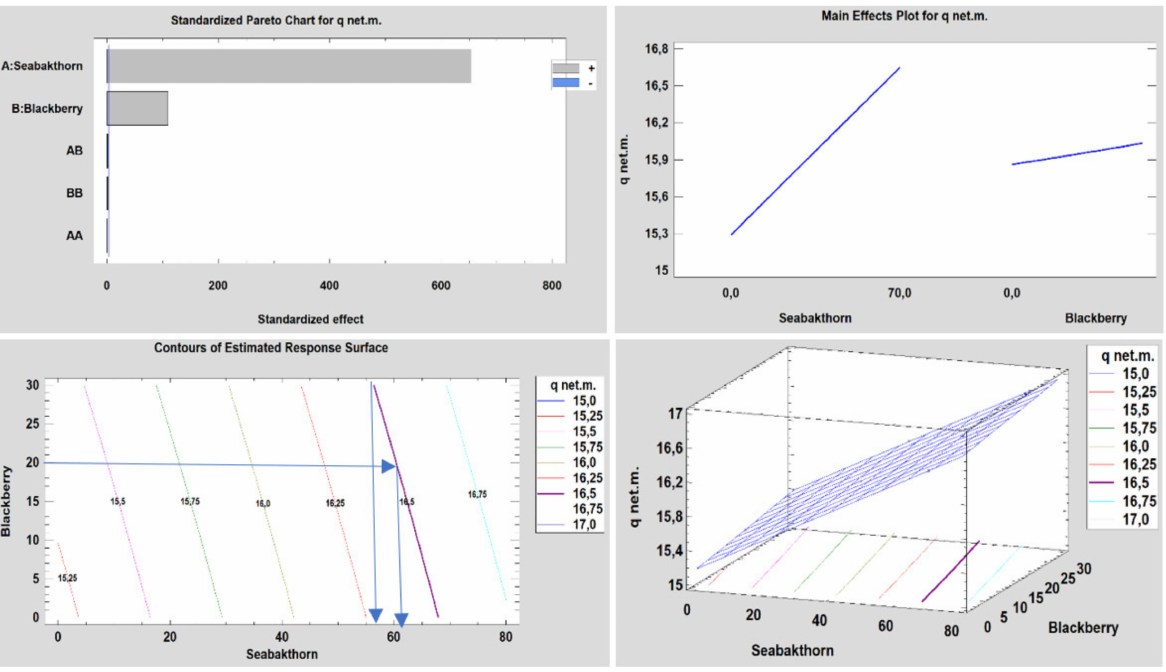
Figure 1. Graphical representation of the net calorific value at humidity of 10% (q p,net, M = 10%) de- pending on the percentage of raw material constituents (seabuckthorn biomass + blackberry +